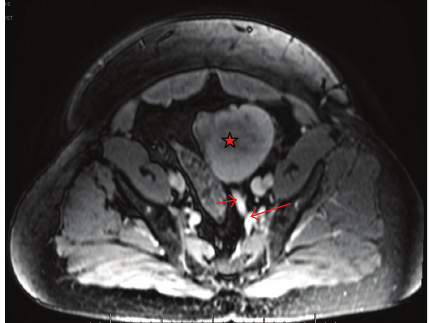
Figure 3: Venous Phase T1-weighted MRI image (transverse view) showing anomalous venous drainage from ectopic left kidney and mass (star). Left renal vein (short arrow) draining into left internal iliac vein (long